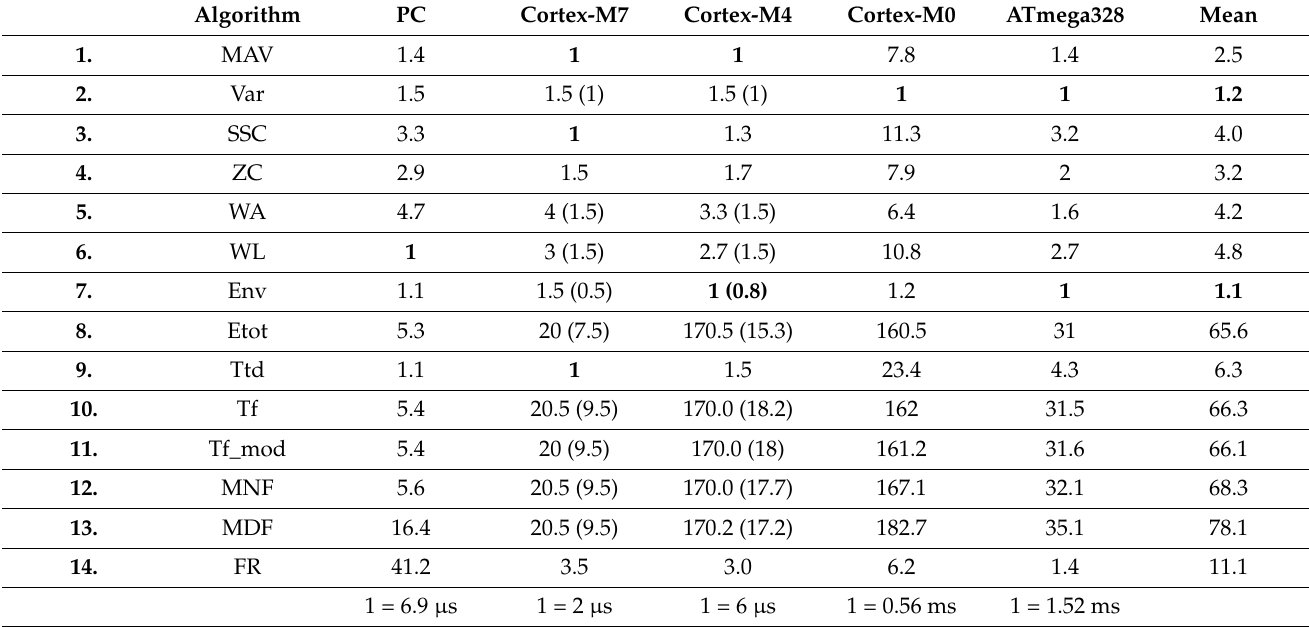
Table 3. Computational times for different algorithms across different platforms. Each column except for the last is normalized with respect to the quickest algorithm. The values presented in parenthesis are the result of using CMSIS-DSP functions which were possible only for some platforms. In the case of similar or longer processing times of the CMSIS-DSP compared with native functions, the parenthesized values are omitted. The bottom row contains information about the absolute processing time in the case of a 128-sample-wide window. The last column presents the mean of the individually normalized processing times of each algorithm. Values indicated by bold text are the ones with the best